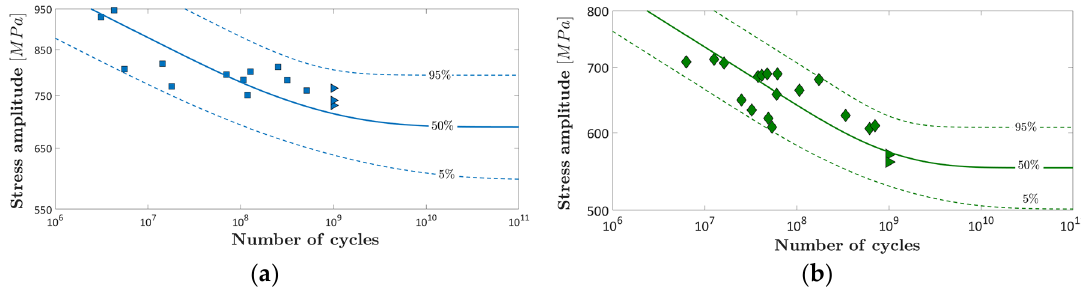
Figure 7. Marginal P–S–N curves (median, 0.05-th and 0.95-th quantiles): ( a ) hourglass with V 90 = 55 mm 3 ; ( b ) Gaussian with V 90 = 5163 mm 3 .